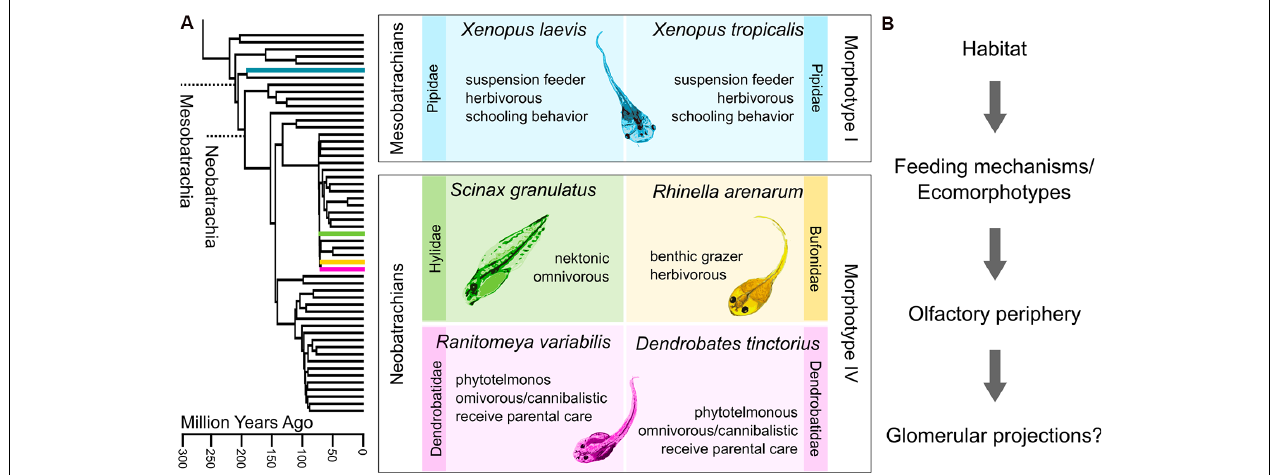
FIGURE 1 | Diversity of anuran tadpoles used in this study. (A) The phylogenetic tree on the left is pruned from Pyron (2014), which originally includes 3,309 species. The four families to which the six examined species belong are highlighted. The middle panel describes the six species based on phylogeny, ecology, and morphology. Both Xenopus species belong to earlier diverging mesobatrachians, lack keratinized mouthparts (morphotype I), and are thus obligate suspension feeders. The four neobatrachian species can all be classified as morphotype IV. Their developed mouthparts enable them to scrape off food from the substrate. The two dendrobatid species both receive parental care and mostly live in pools in leaf axils or bromeliads. Morphotype distinction follows (Orton, 1953) and ecomorphotypic categorizations are based on (Altig and Johnston, 1989). (B) Experimental concept of this study. We tried to examine whether the glomerular organization in the main olfactory bulb (MOB) of tadpoles is influenced by the respective habitat or feeding mechanisms in the distantly related